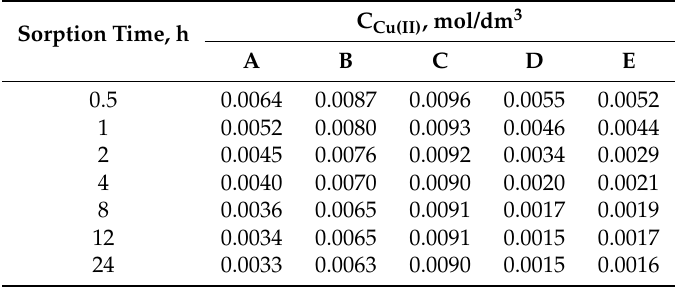
Table 5. Sorption time-dependent concentration of Pb(II) ions after the sorption on